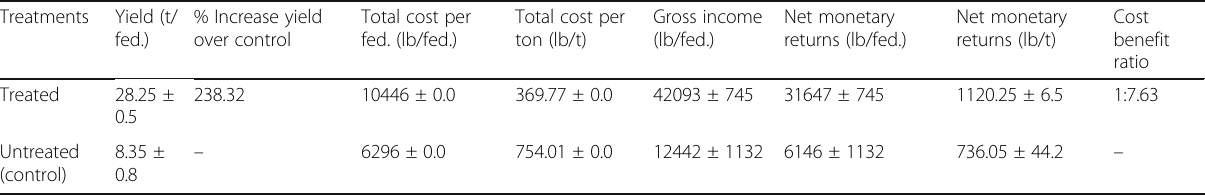
Table 6 Economics of insecticides and botanical formulations sequence treatments used against Tuta absoluta on tomato plants Treatments Yield (t/ % Increase yield fed.) over control